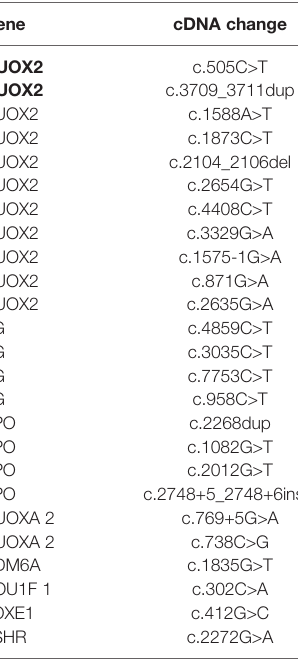
TABLE 2 | Potential pathological variants detected in the present